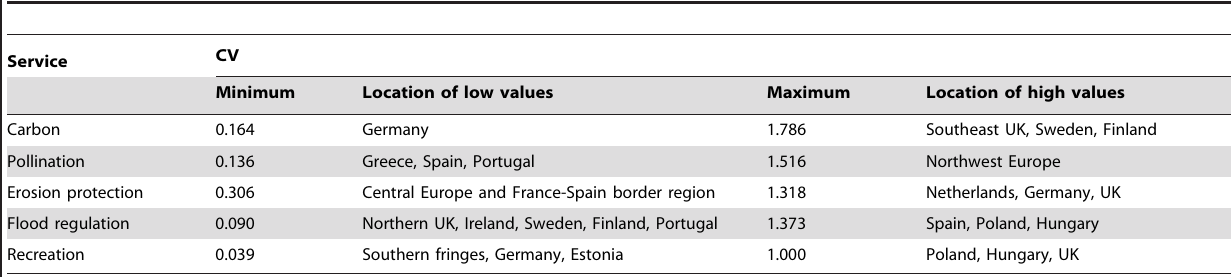
Table 3. Minimum and maximum coefficients of variation for NUTS2 regions between service estimates; low values indicate agreement between the different ES estimates, high values indicate large variation between reported